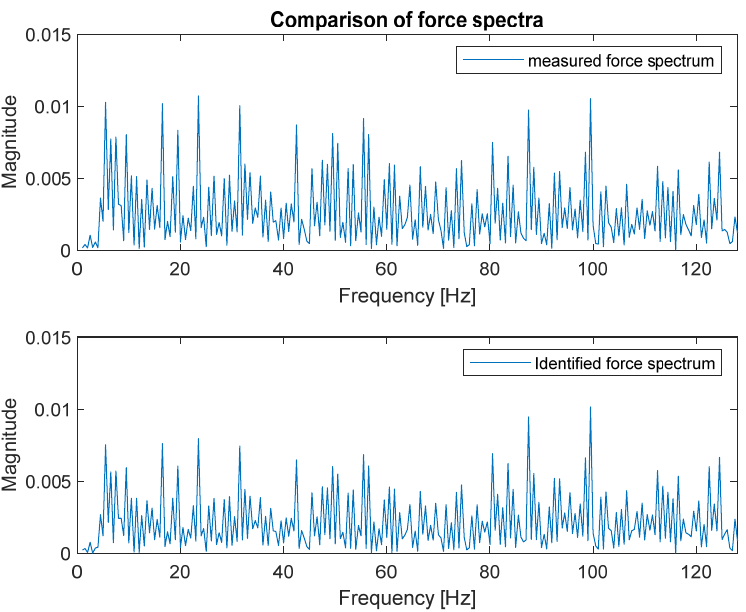
Figure 9. Comparison of measured and identified force spectra (modal filter method).